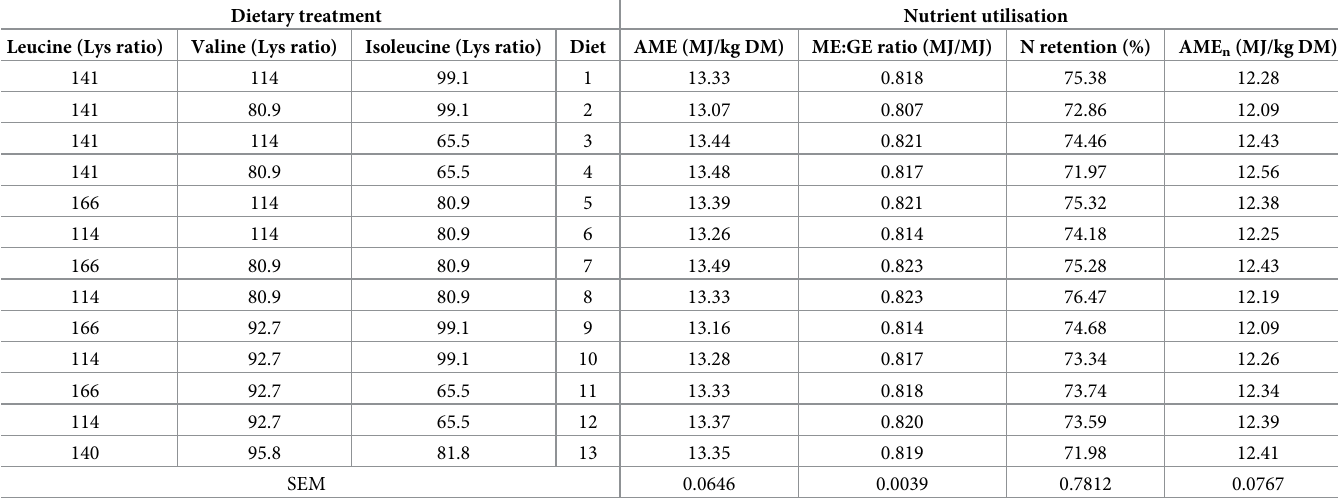
Table 7. Effects of dietary treatments on nutrient utilisation from 24 to 27 days post-hatch. Dietary treatment Nutrient